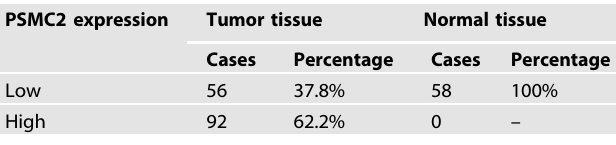
Table 1. Expression patterns of PSMC2 in ovarian cancer tissues and normal tissues revealed in immunohistochemistry